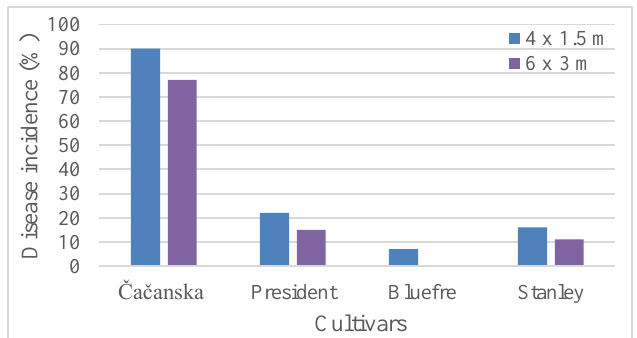
Figure 5. Incidence of blackhorn dotty caused by Polystigma rubrum in 2017